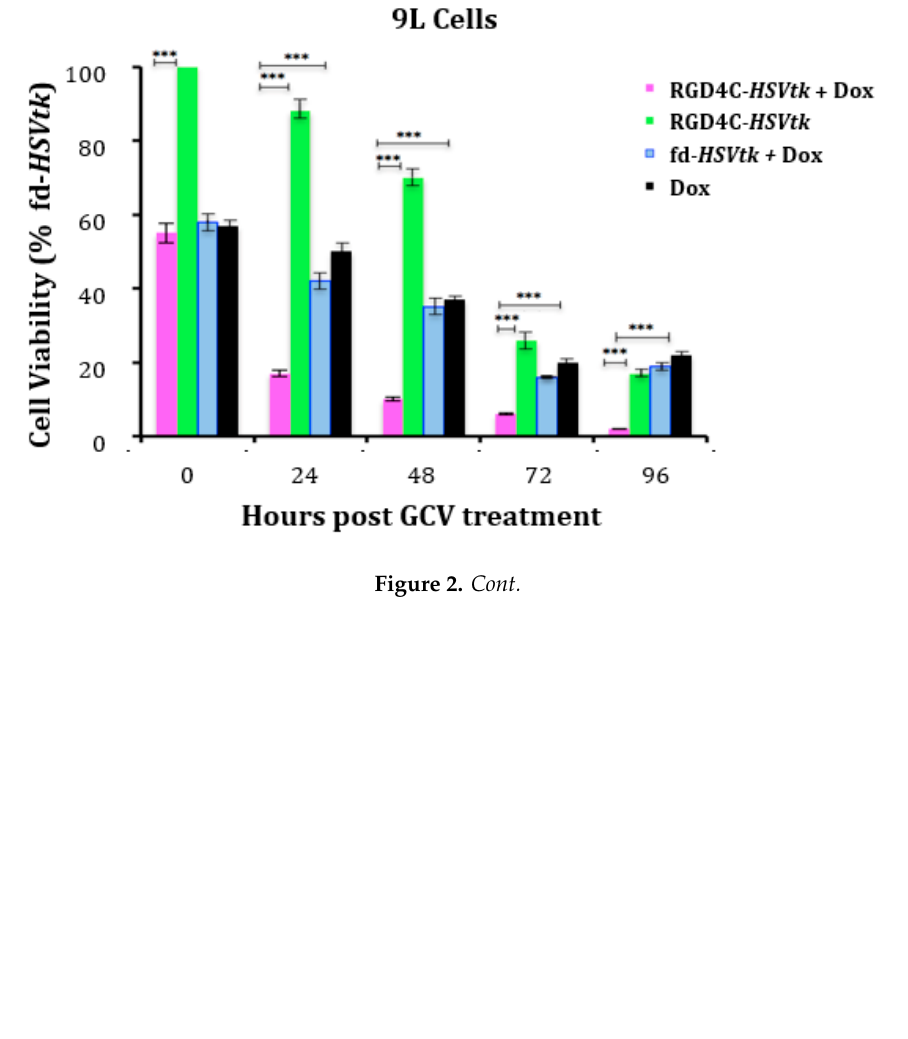
Figure 2. Dox amplifies the suicide gene killing of cancer cells by targeted RGD4C/AAVP- HSVtk . 9L ( A ) and M21 ( B ) cancer cells grown in 48-well plates, 60–80% confluent, were transduced with the targeted RGD4C/AAVP- HSVtk (RGD4C- HSVtk ) vector carrying the HSVtk gene or control nontargeted AAVP- HSVtk (fd- HSVtk ) in the presence or absence of Dox, 0.5 μΜ for 9L and 0.6 μΜ for M21 cells. The cells were treated with GCV (20 μ M) at day 3 post-vector transduction and renewed daily. Cancer cell killing was quantified at 0, 24, 48, 72 and 96 h post-GCV treatment by using the trypan blue exclusion methodology. Results were normalized to the nontargeted fd- HSVtk vector. The experiments were repeated twice in triplicates, and the results shown are representative of one experiment. * p < 0.05, ** p < 0.01, *** p < 0.00 and n.s: nonsignificant